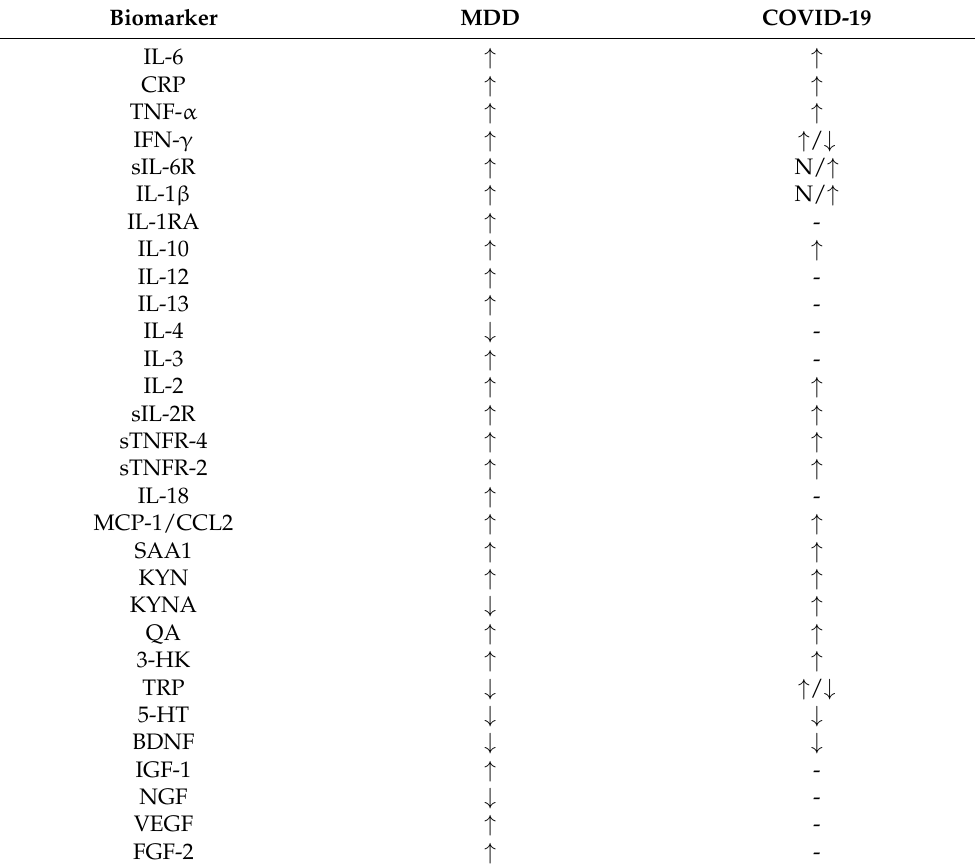
Table 1. Common biomarkers of MDD compared to findings in COVID-19 (+) patients.